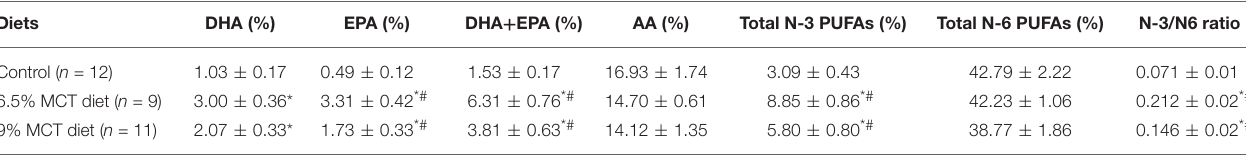
TABLE 2 | Effects of the diets on blood omage-3 and omega-6 levels. Diets